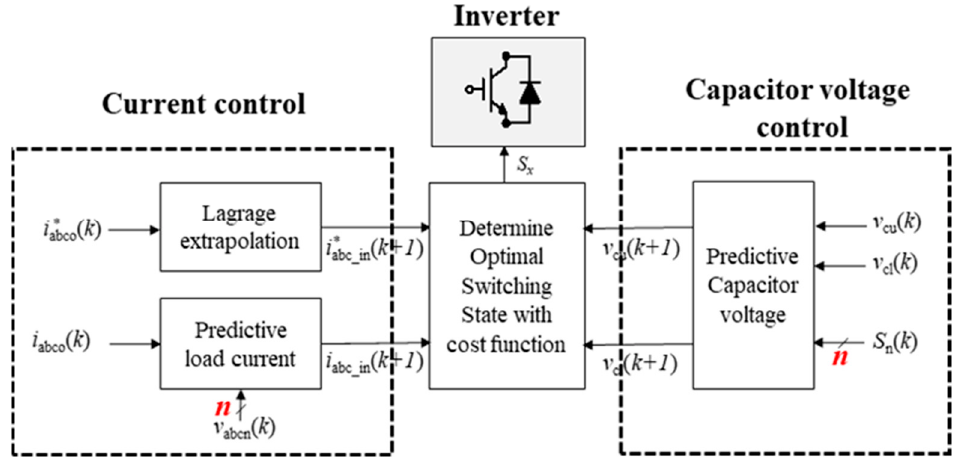
Figure 2. Block diagram of model predictive control for four-leg inverters.